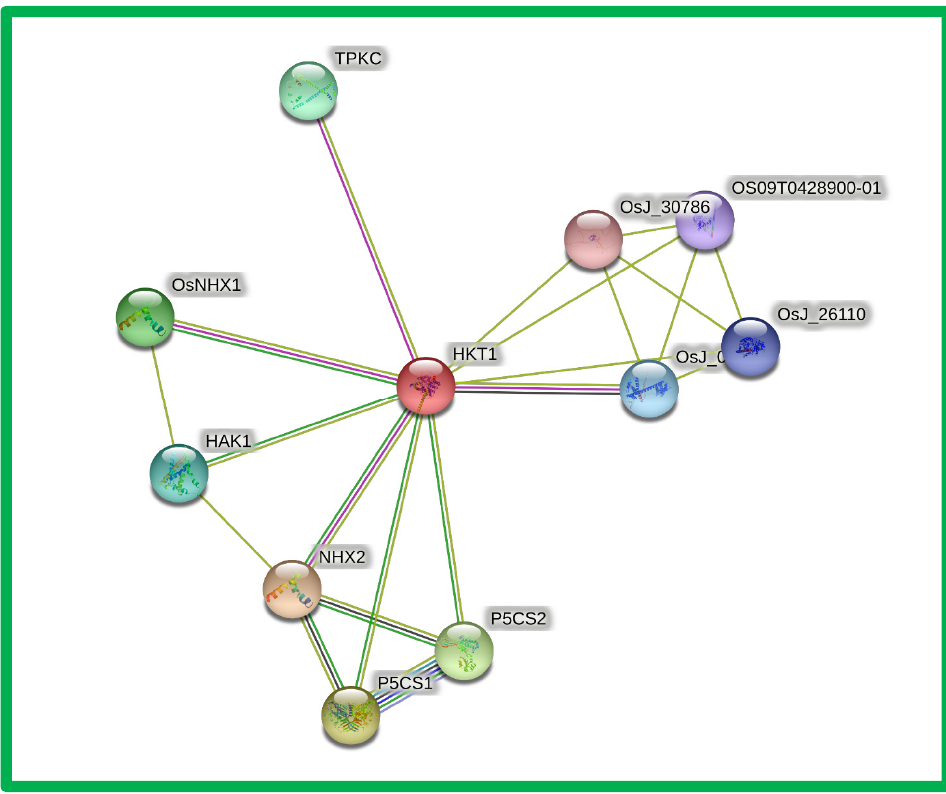
Figure 6. Predictive protein interaction analysis of OsHKT1 genes in rice. Our reference protein is in the middle in red. Table 2. Predicted function partners of OsHKT1 in Oryza Sativa.